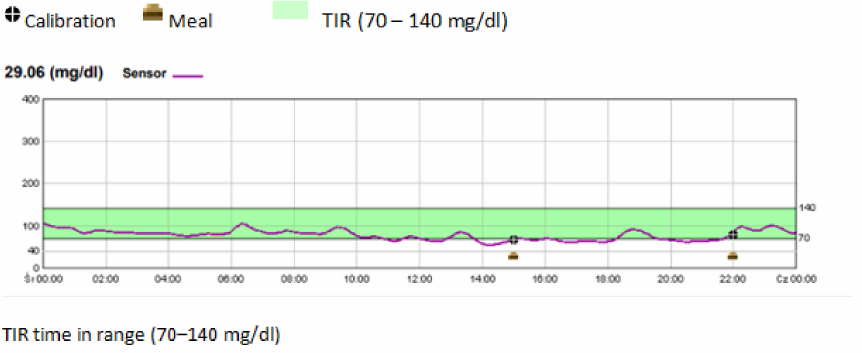
Figure 1. Continous glucose monitoring - example of severe hypoglycemia episodes in gastrostomy fed